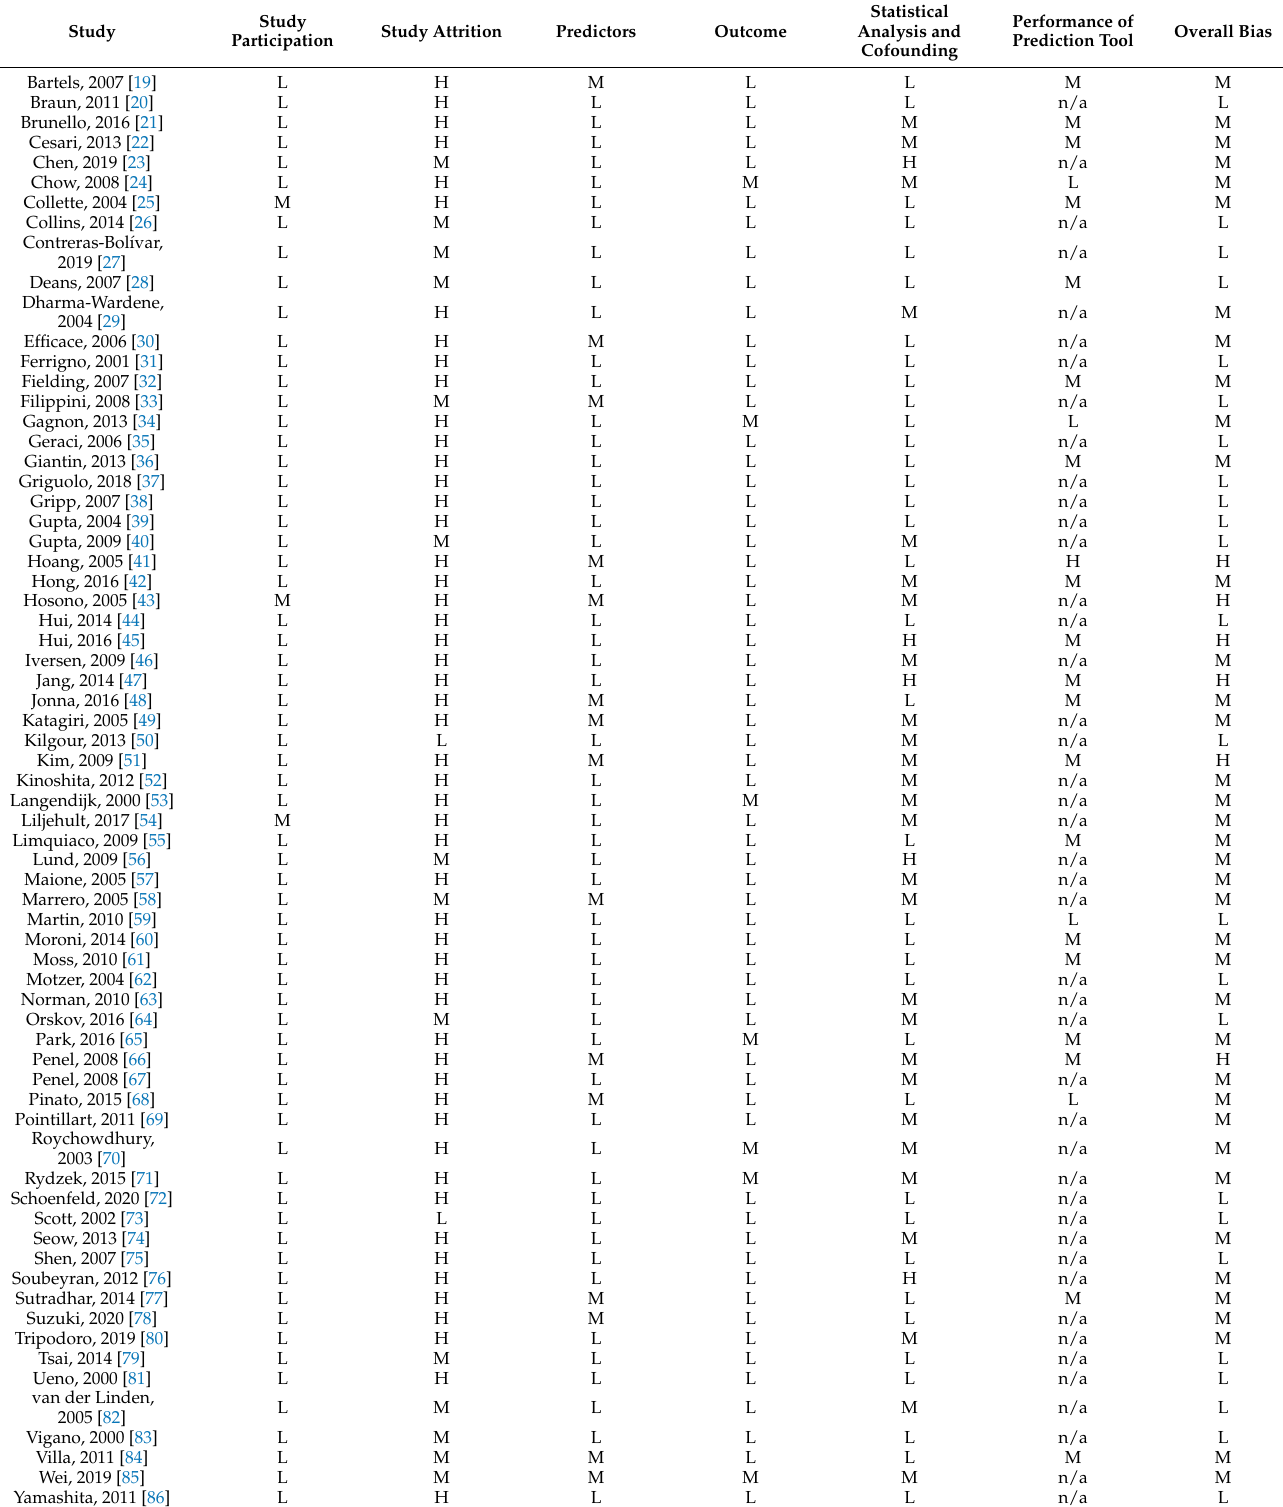
Table 2. Summary of risk-of-bias